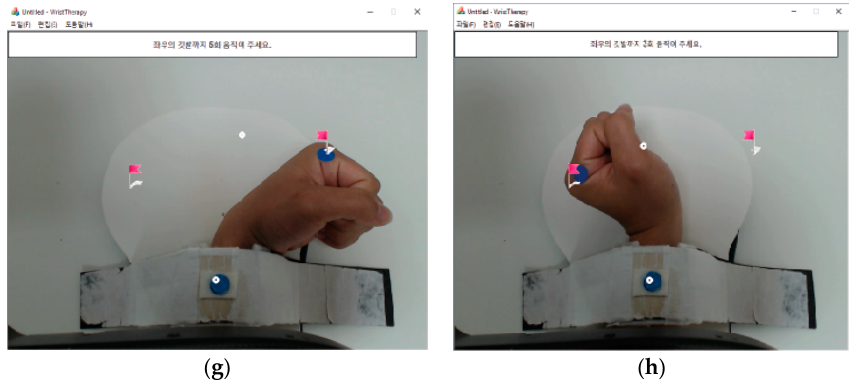
Figure 2. The first section: ( a ) Preparation of the unhealthy wrist, ( b , c ) the extensible and flexible movement of the unhealthy wrist, respectively; the second section: ( d ) Preparation of the healthy wrist, ( e , f ) the extensible and flexible movement of the healthy wrist, respectively; the third section: ( g , h ) The speed-up movement of the unhealthy wrist.